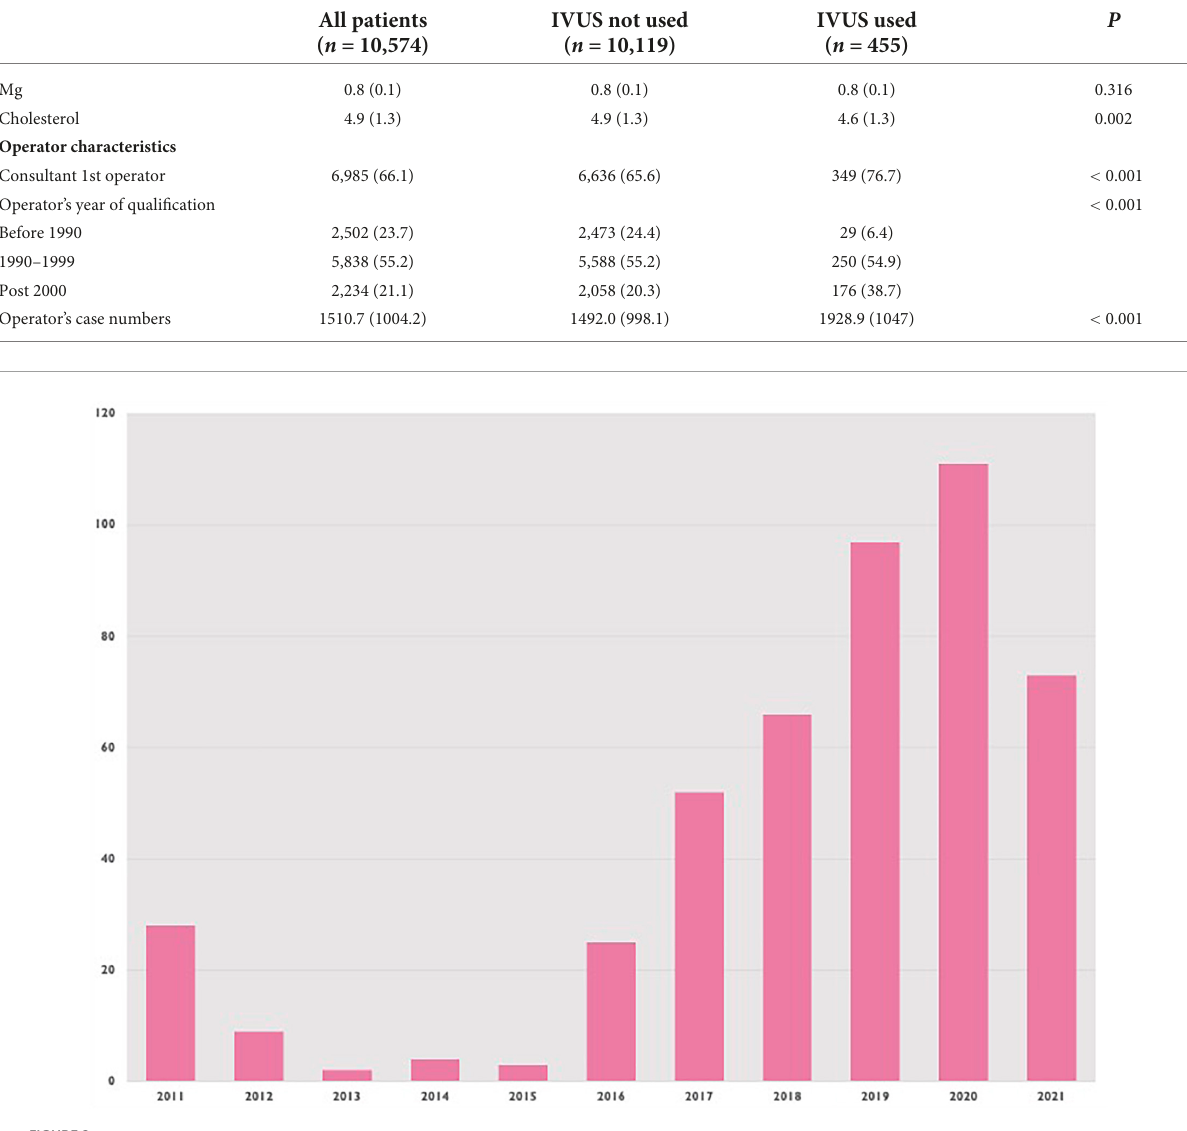
FIGURE2 Absolute number of IVUS procedures performed in PCI-naive patients by